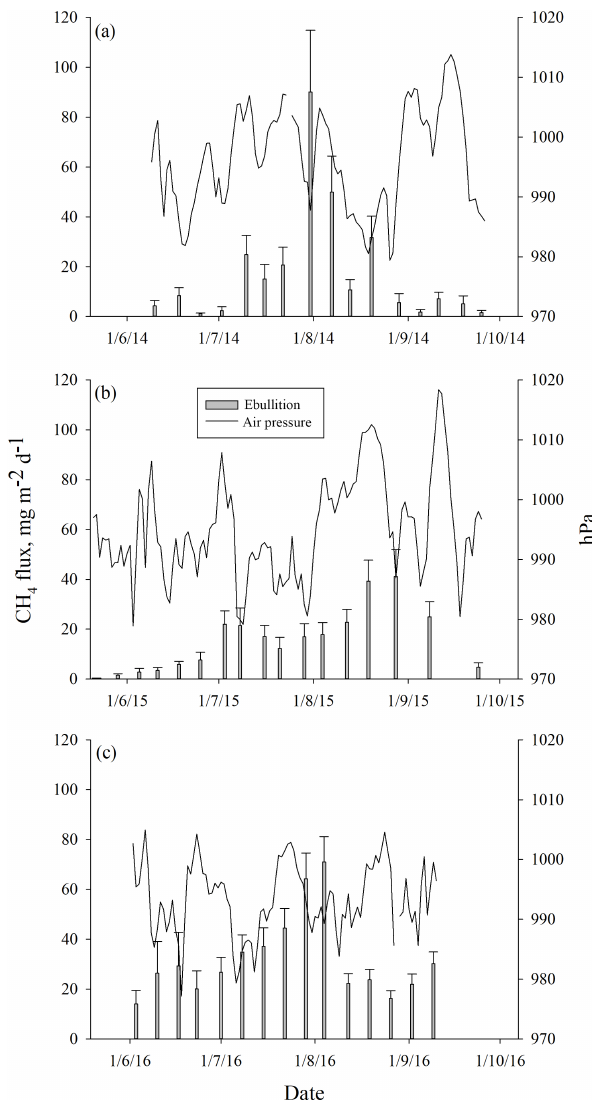
Figure 5. Mean weekly methane ebullition from all surfaces compared to atmospheric pressure measured in Siikaneva bog in (a) 2014, (b) 2015 and (c) 2016.